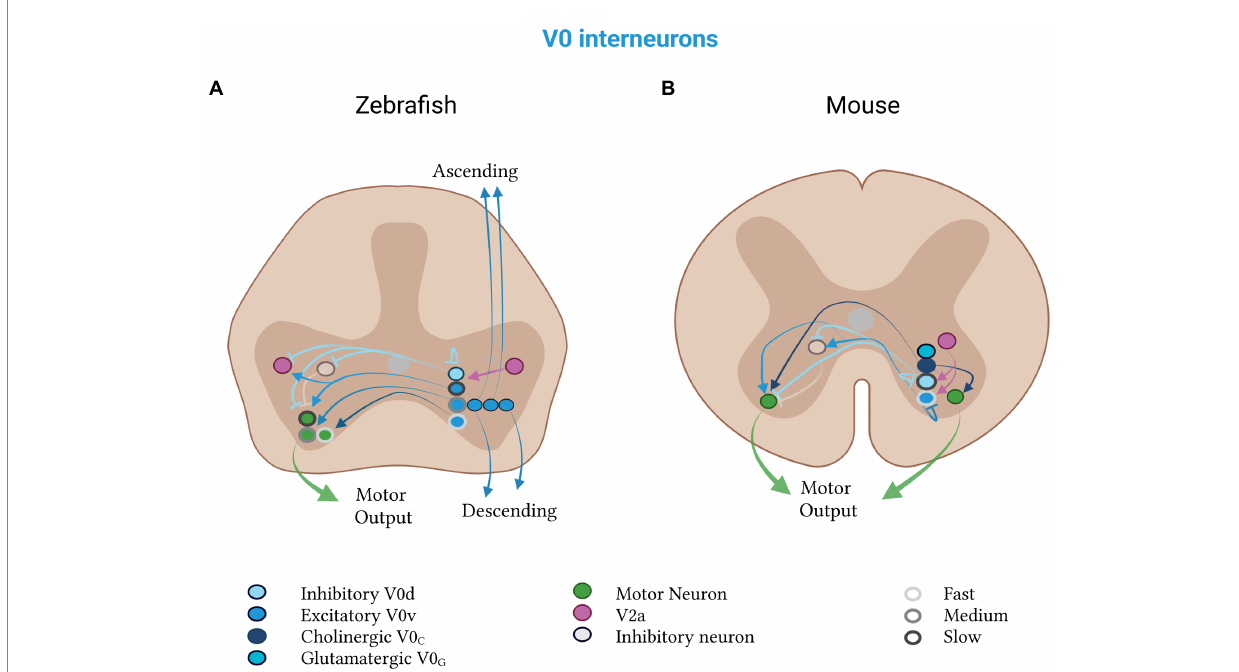
FIGURE 4 Mixed V0 subtypes in zebrafish and mice. V0d neurons (light blue) inhibit, and V0v neurons (medium blue) excite, contralateral motor neurons (green). (A) Zebrafish V0d neurons receive input from V2a neurons (pink) and project to other V0d, contralateral inhibitory (gray) and ipsilateral excitatory (pink) neurons. The V0v neurons project to V2a neurons and divide into a rhythmic and a non-rhythmic group. The rhythmic group is further split into fast (light gray, outline), medium (medium gray, outline) and slow (dark gray, outline) subtypes, which project to motor neurons of the respective speed class. Excitatory V0v neurons also segregate by projection pattern into ascending, descending and bifurcating subpopulations. (B) Mouse V0d and V0v neurons control slow and fast speeds, respectively. Both classes receive input from V2a neurons. The V0v class additionally projects to contralateral neurons (gray), which inhibit motor neurons. Mouse-specific V0c neurons (dark blue) are cholinergic and project to motor neurons on both sides of the spinal cord. Mouse-specific V0g neurons (turquoise) are glutamatergic and their projection pattern is as of yet